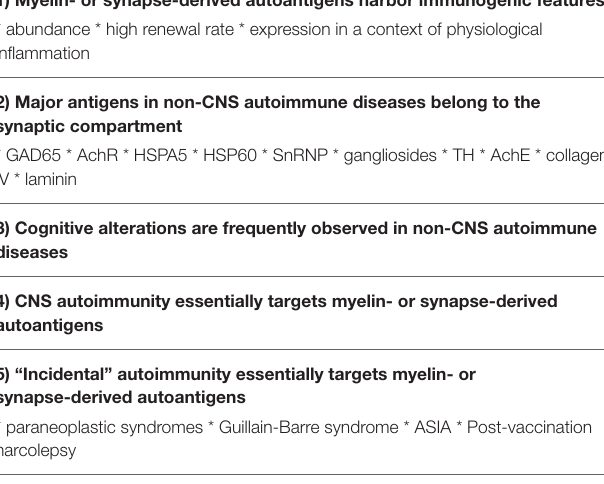
TABLE 2 | Five data-driven arguments support the brain superautoantigens theory. 1) Myelin- or synapse-derived autoantigens harbor immunogenic features